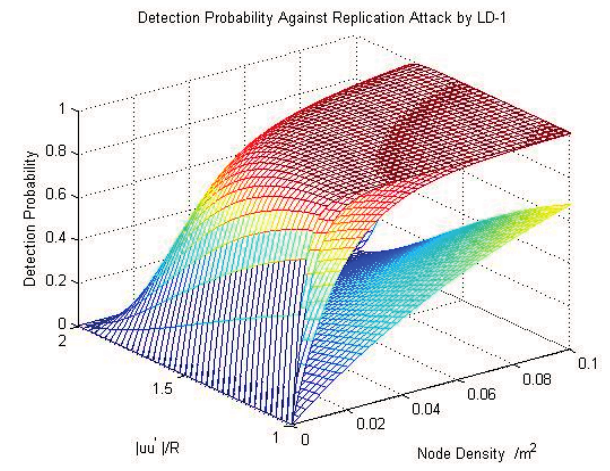
Figure 2. The result of detection probability for resisting replication attacks by using LD-1. 2R ≤ |uu′| < 3R : In this case, we could use LD-2 to detect the replicas of the compromised nodes,